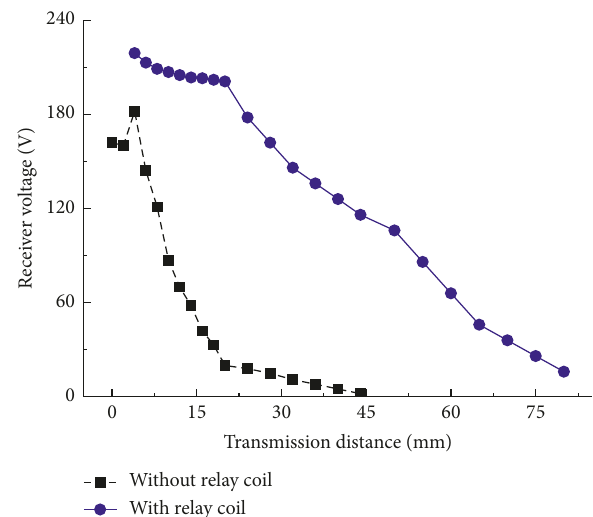
Figure 17: Receipt of voltage change of the experimental device, with distance changing with or without relay coil.